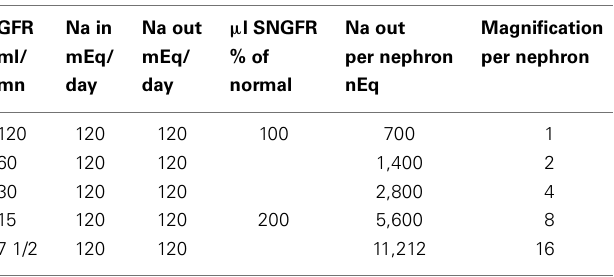
Table 1 |Adaptation in Na excretion per nephron in advancing CRD on a constant salt intake